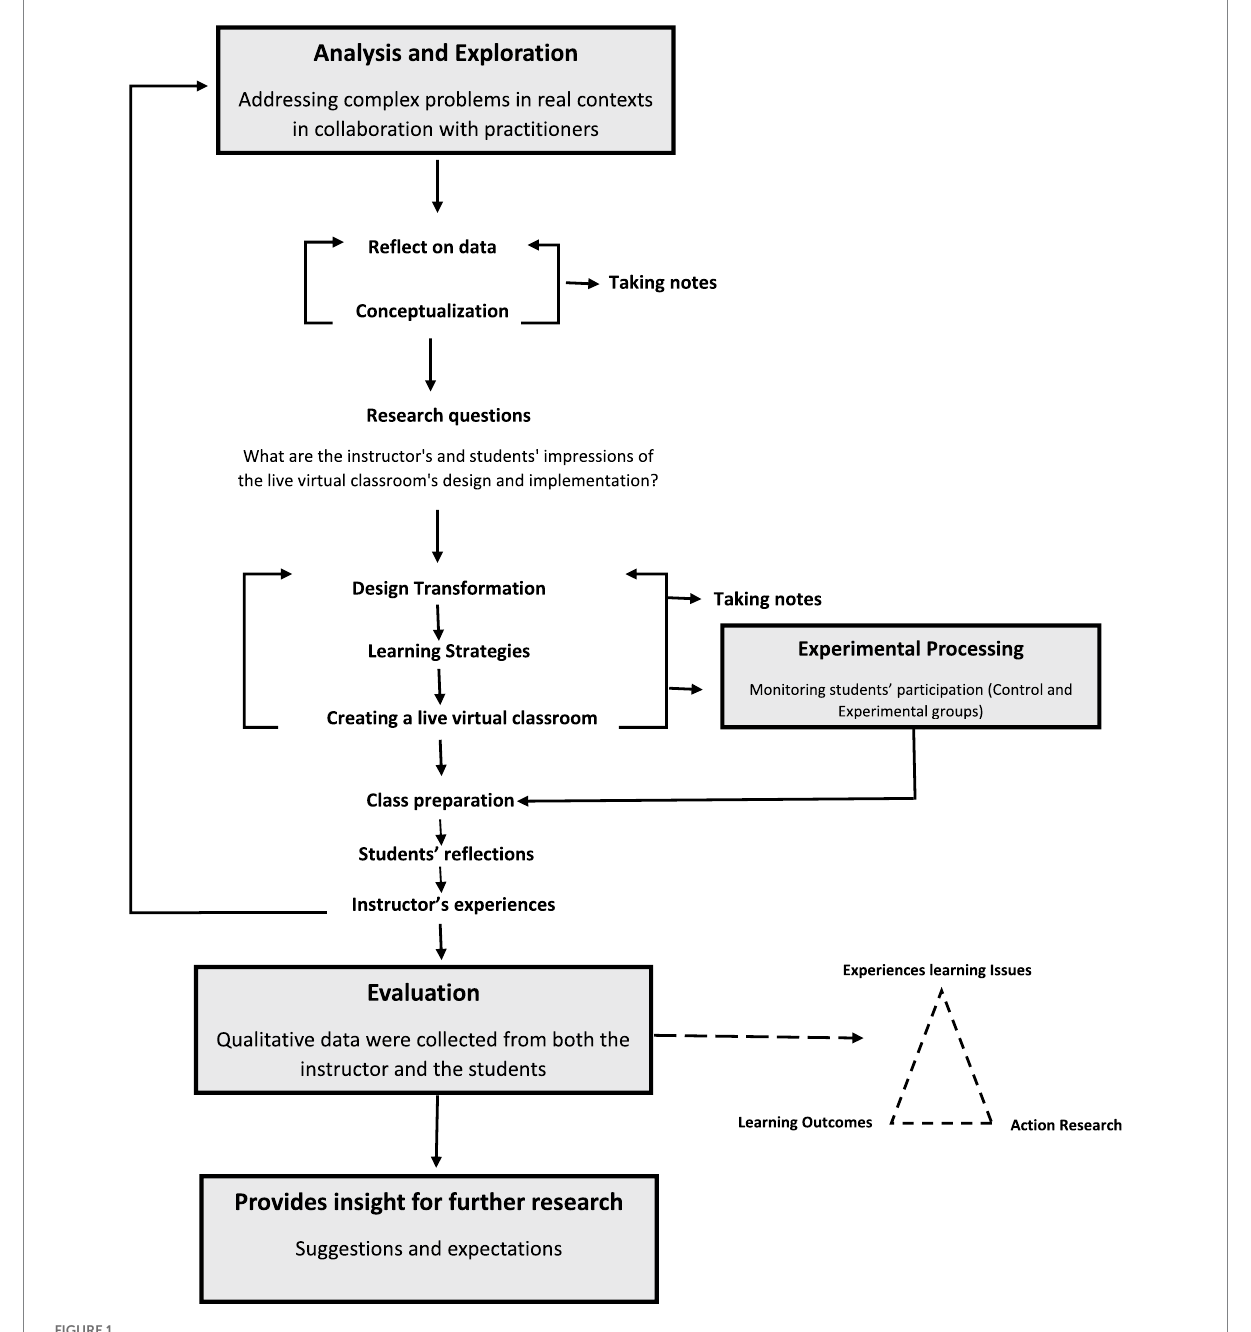
FIGURE 1 Action research method to improve social presence in virtual